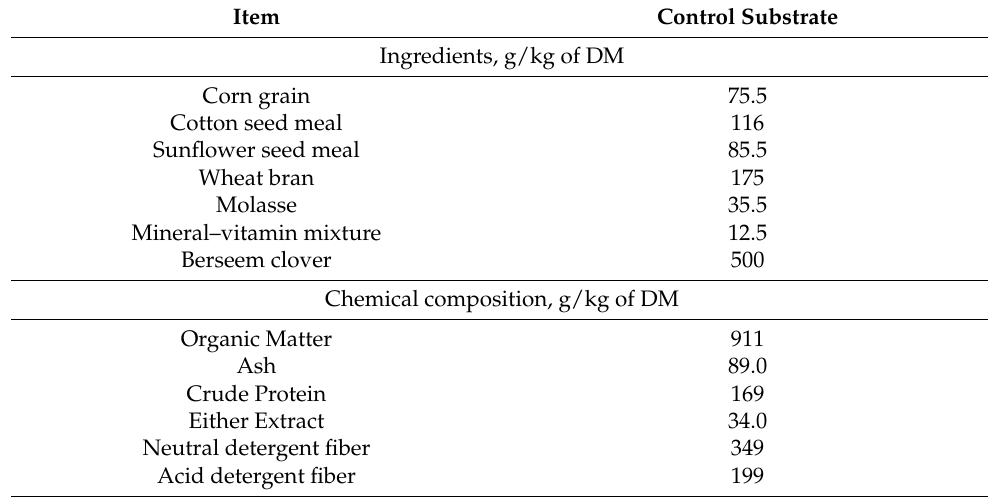
Table 1. Ingredients and chemical composition of the control diet.